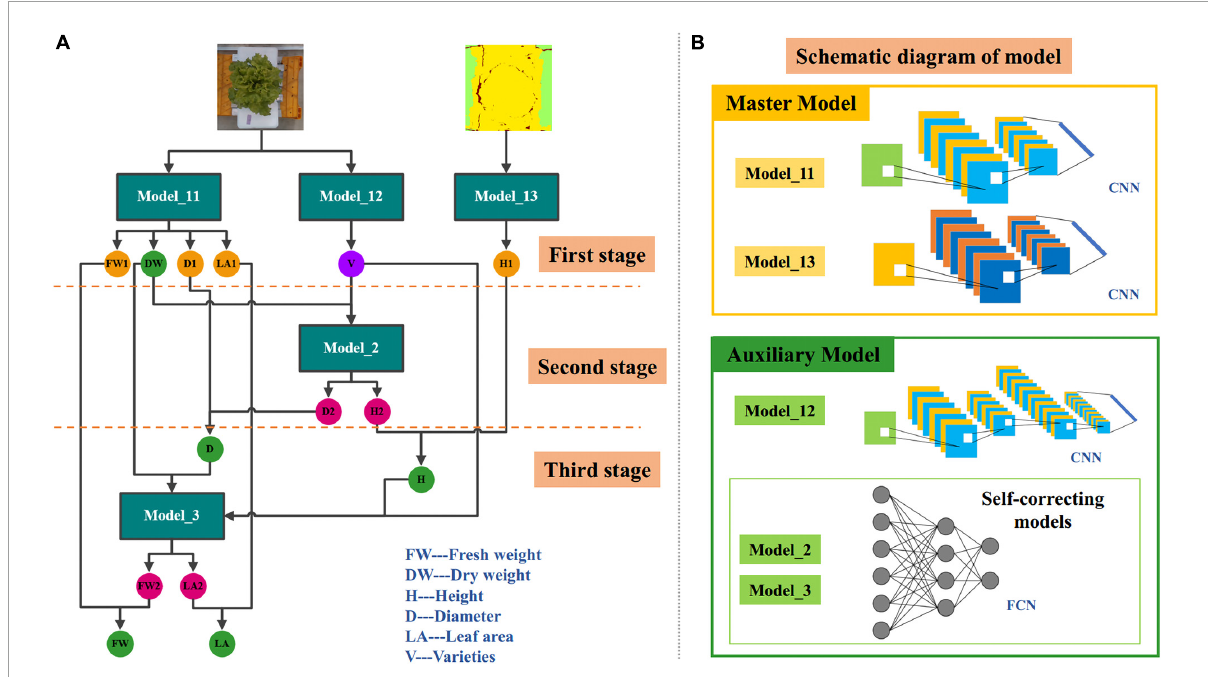
FIGURE4 Architecture of the three-stage multi-branch self-correcting network (TMSCNet). (A) The principle of TMSCNet. (B) Schematic diagram of the models in the TMSCNet.